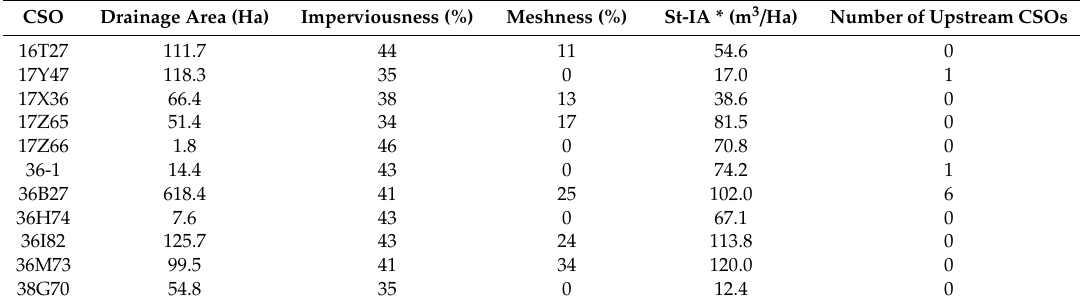
Figure 1. Urban drainage network (UDN), Combined sewer overflows (CSOs), and rivers in the study area. Table 1. CSO-catchments and urban drainage network characteristics. CSO Drainage Area